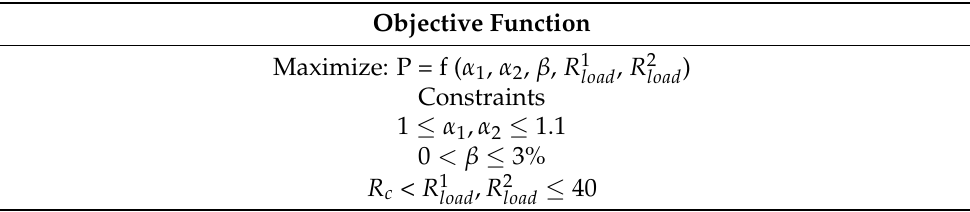
Table 4. Objective function and constraints applied to search for the position of the